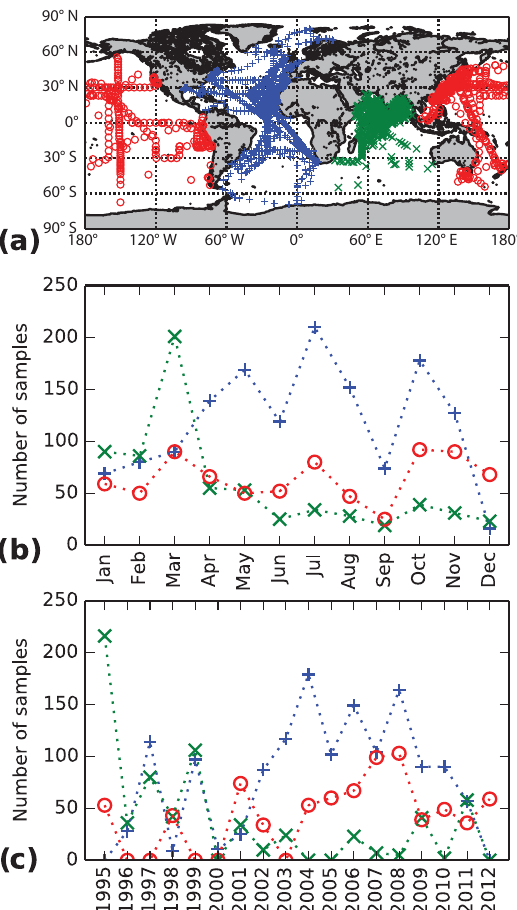
Figure 1. Spatial distribution of the (a) aerosol samples and the distributions of these samples by (b) month and (c) year for the entire database divided according to the main ocean